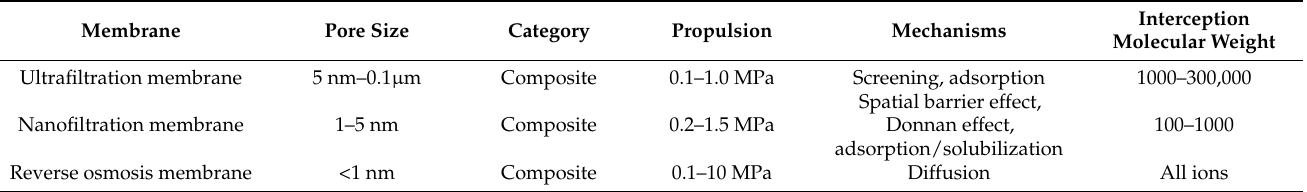
Table 3. Characteristics, mechanism and operating conditions of membrane separation, the core unit of water purifier.